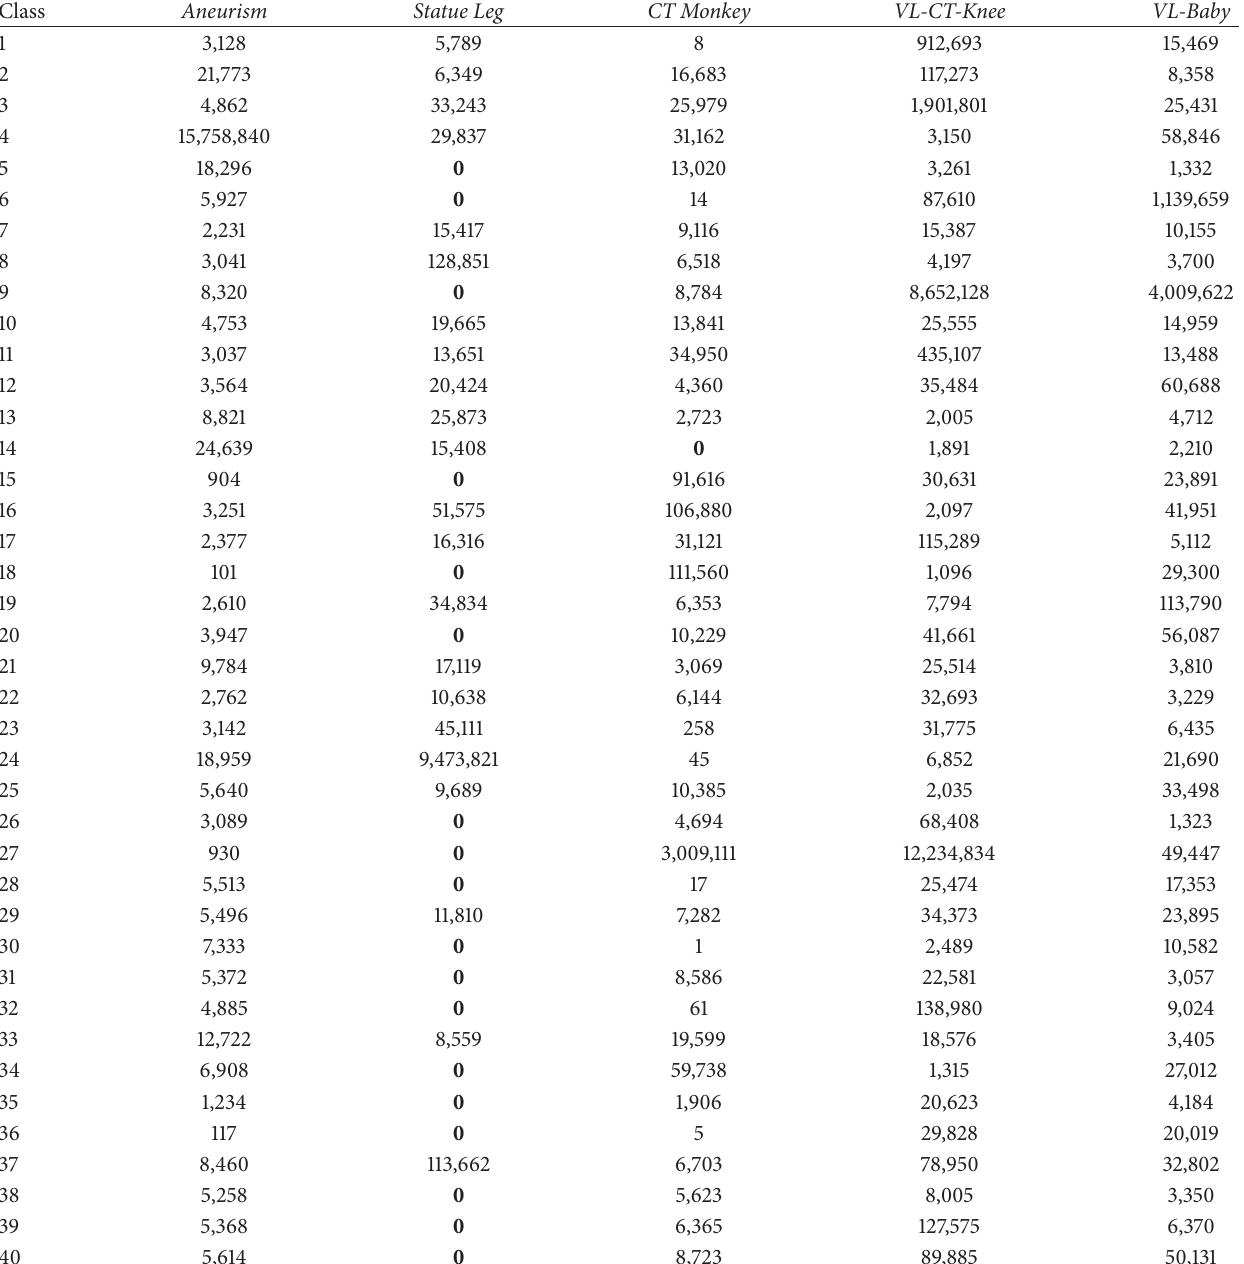
Table 9: Classification of 3D masks according to 1D-KNs with 125 inputs, 40 output neurons, and 10